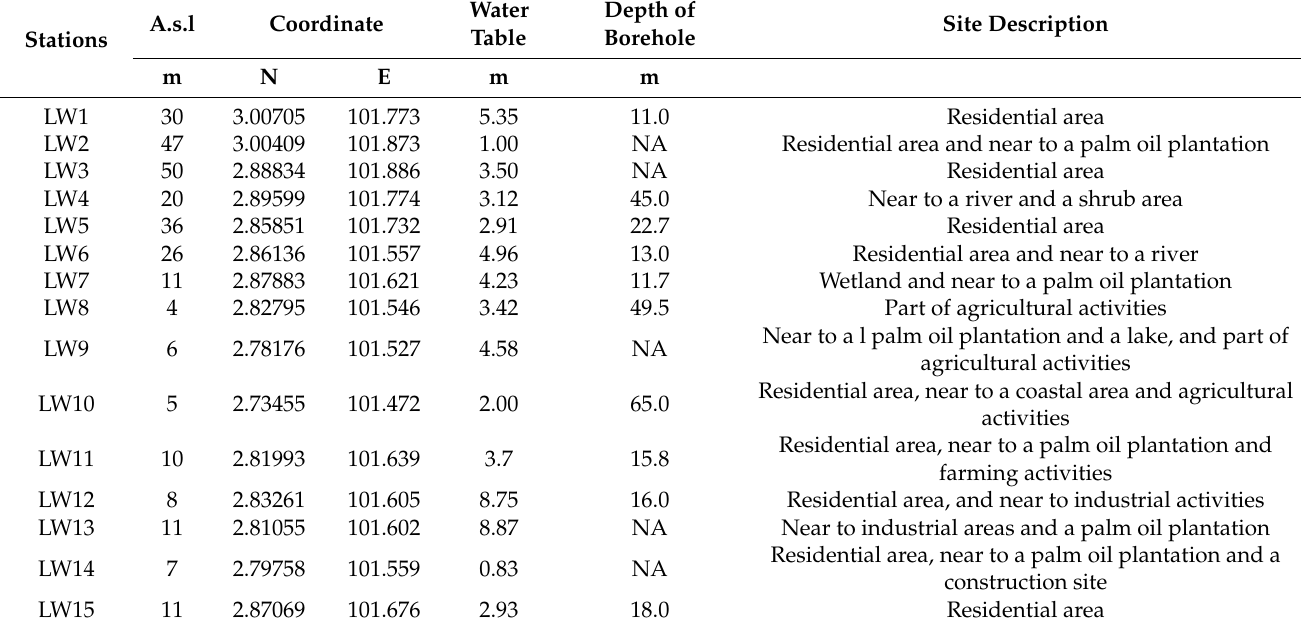
Table 4. Site description of the study